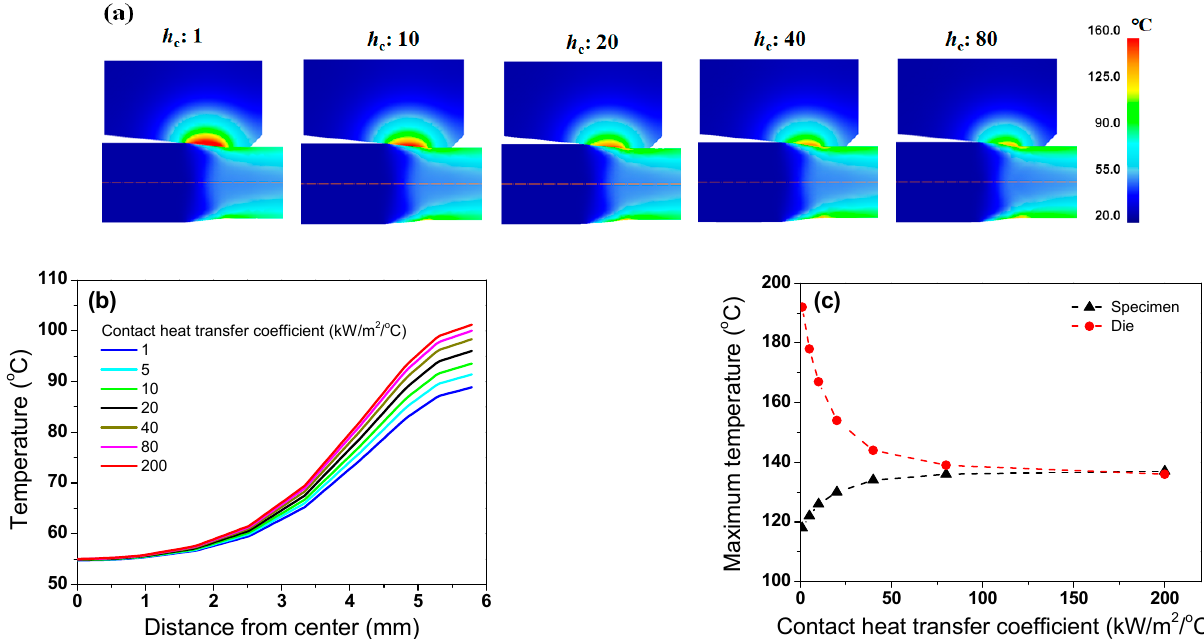
Figure 5. Comparison of temperature ( a ) contours and ( b ) profiles along the radial direction of wire at die exit; ( c ) T max of wire and die vs. contact heat transfer coefficient.